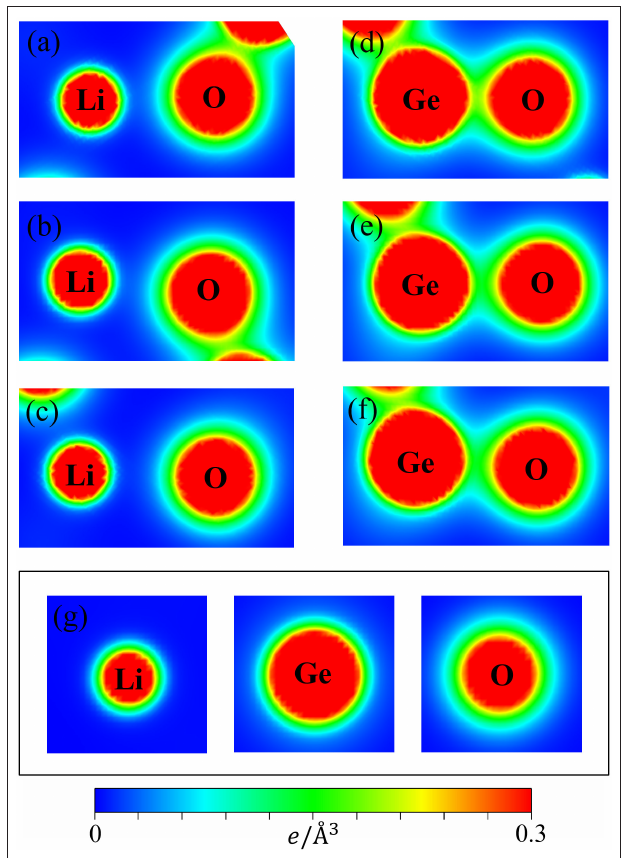
FIGURE 3 | The charge density distribution for the shortest/medium/longest (a–c) Li-O bonds and (d–f) Ge-O bonds and (g) for the isolated (Li, Ge, O) atoms.